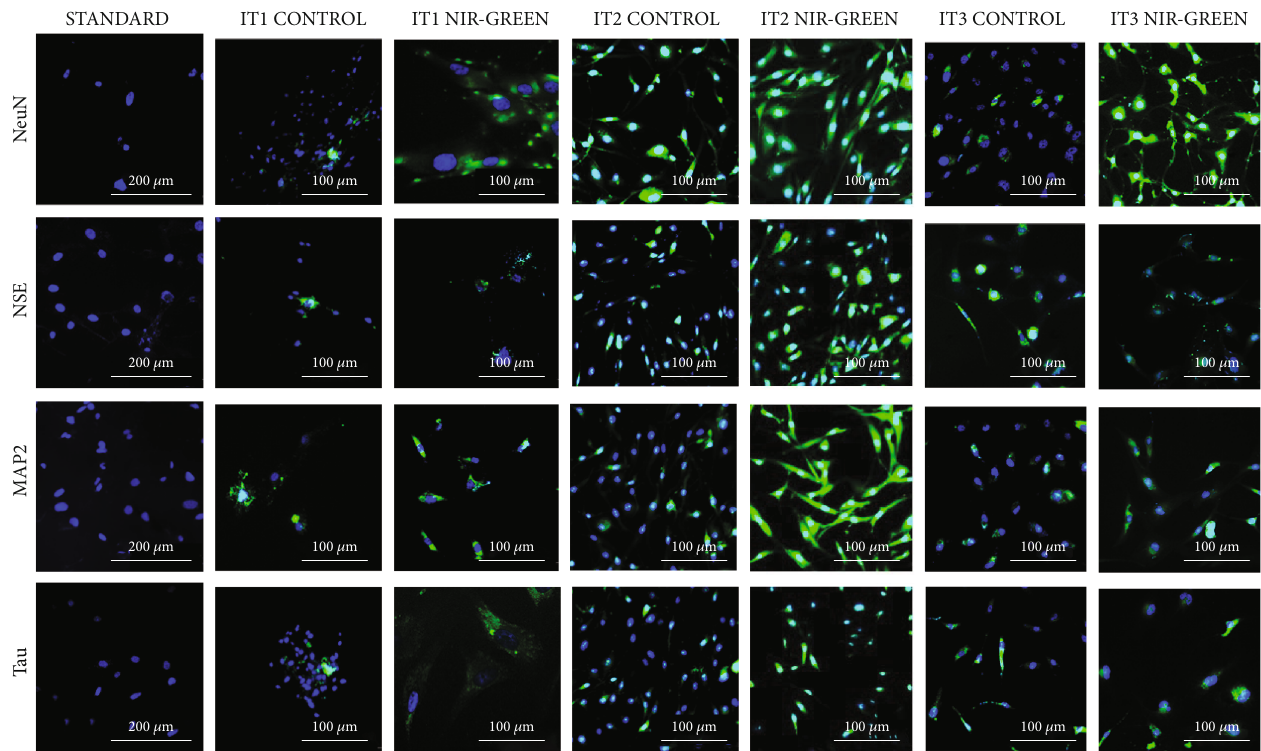
Figure 4: Characterization of early, NSE and NeuN, neuronal markers following transdi ff erentiation media and consecutive laser irradiation treatment. Fluorescent protein detection through fl uorescent microscopy. Fluorescent microscopy revealed the presence of neuronal markers 7 days post-PBM. Scale bar: 100 μ m.